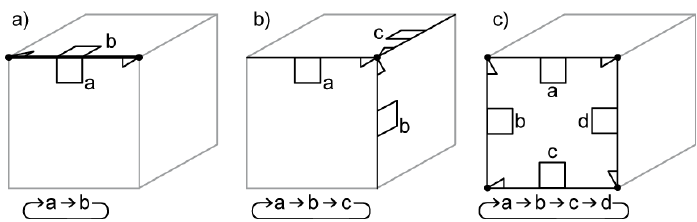
Figure 7. Half-edges in a cell are topologically connected and form: (a) an edge; (b) a star; (c) a loop.